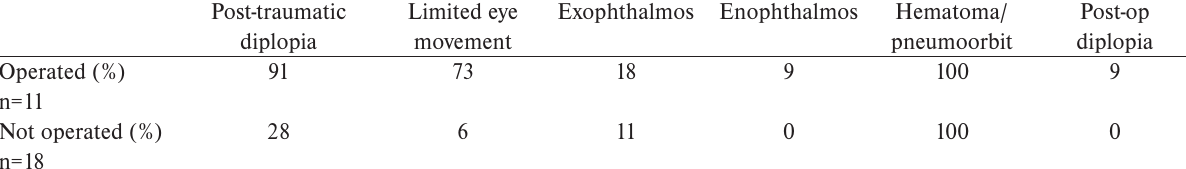
Table 4. Clinical